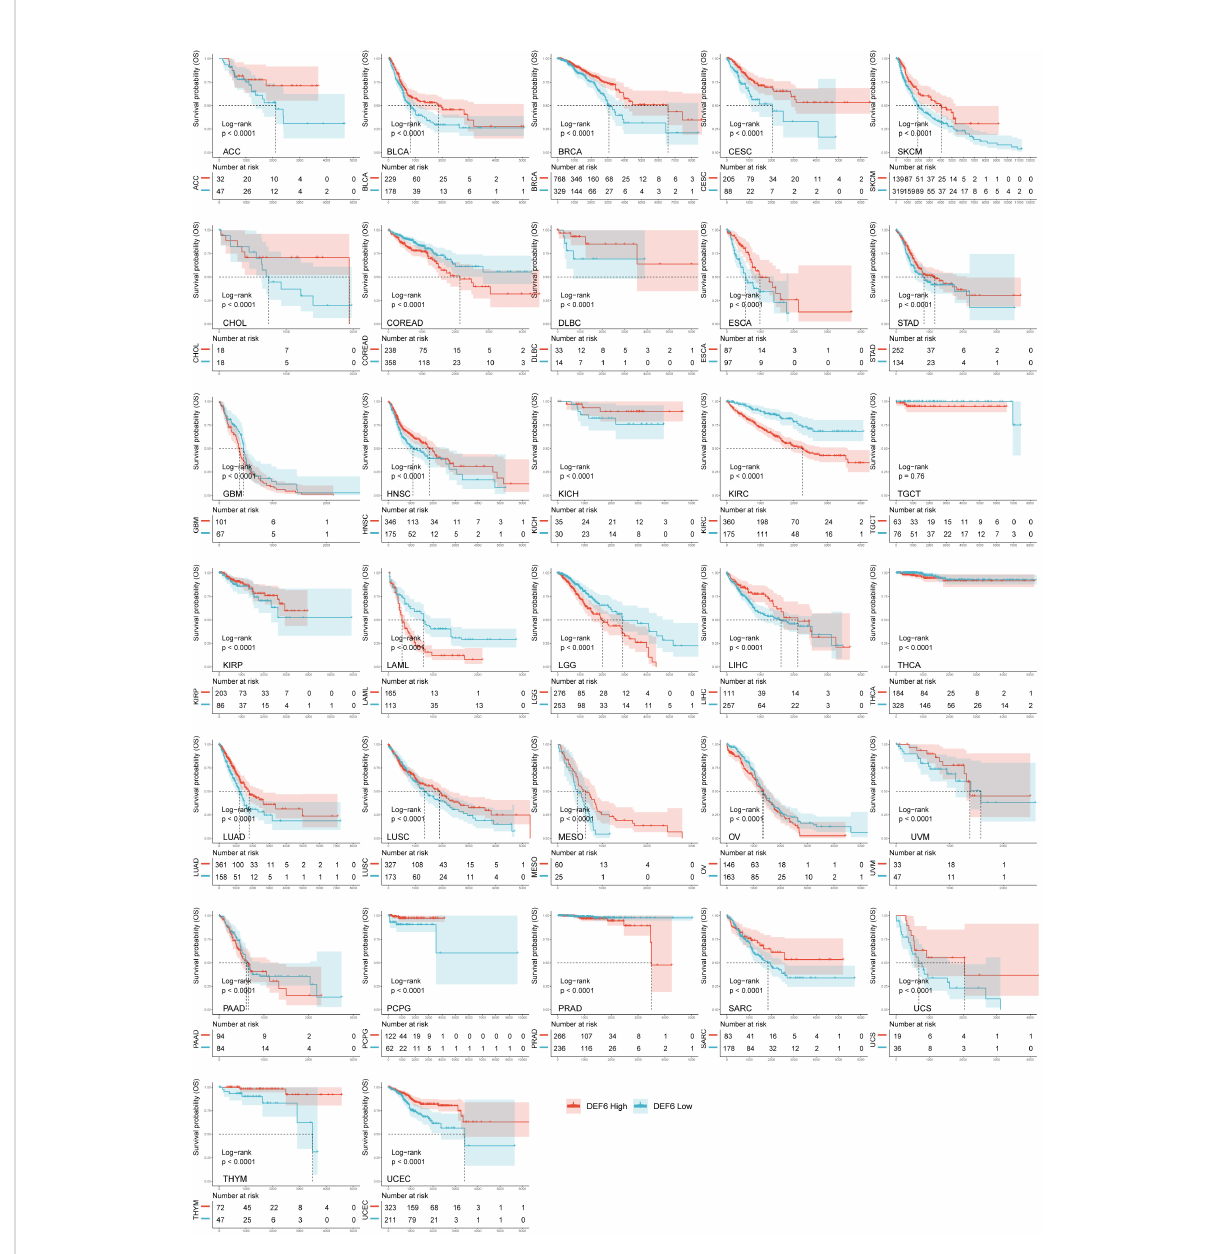
FIGURE 3 Analysis of the overall survival in multitumors with best cut-off